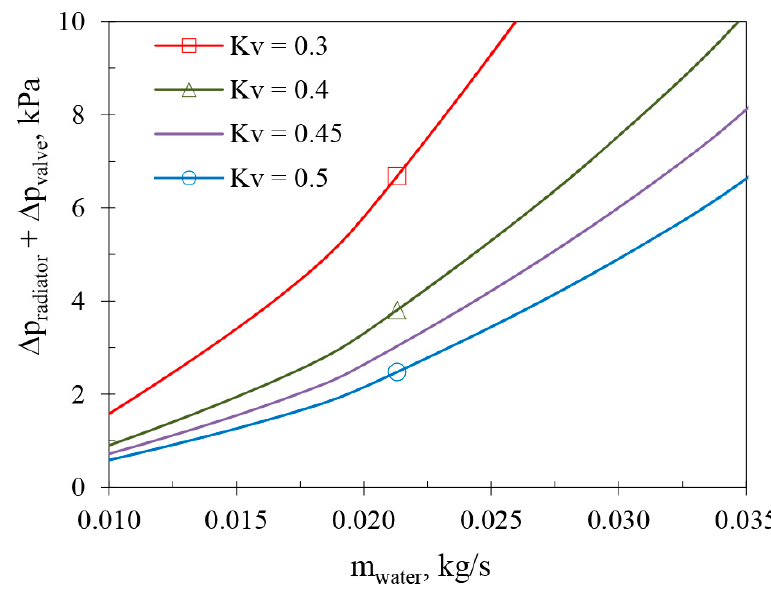
Figure 9. The pressure loss over a thermostatic valve and a conventional radiator at different water flow rates for four K v -values.